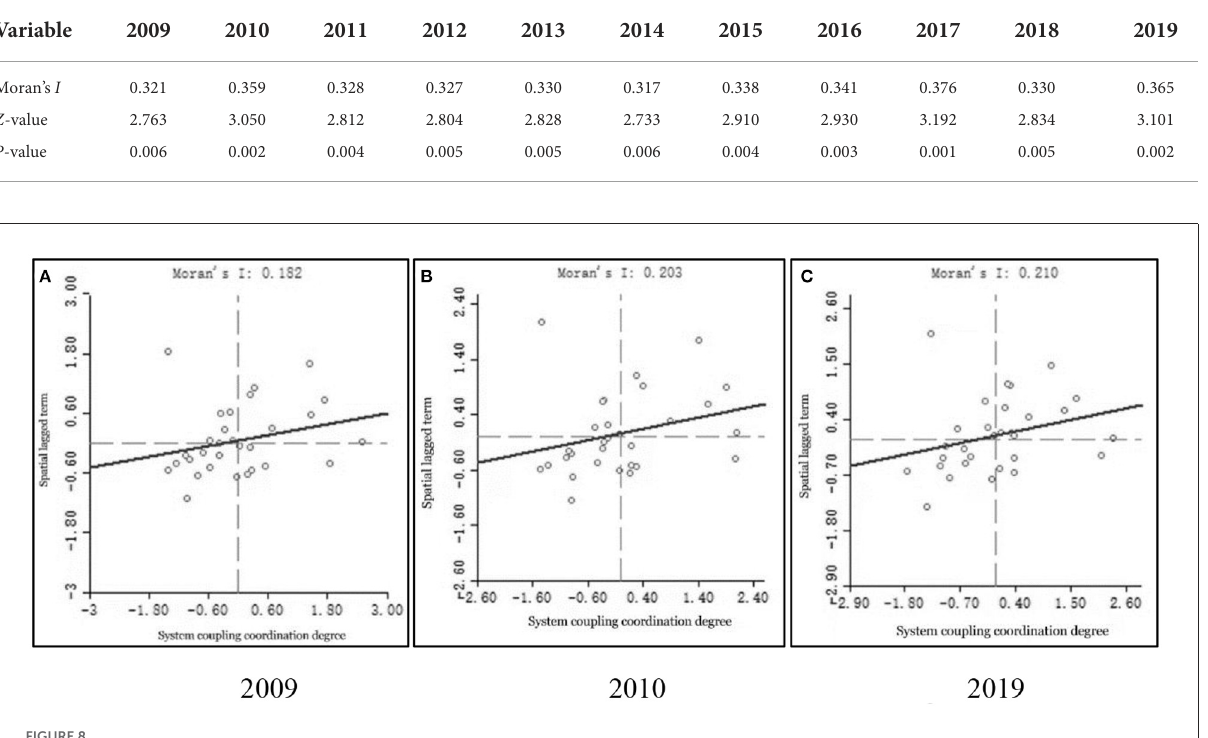
TABLE 6 Results of the Global Moran’s I- test.